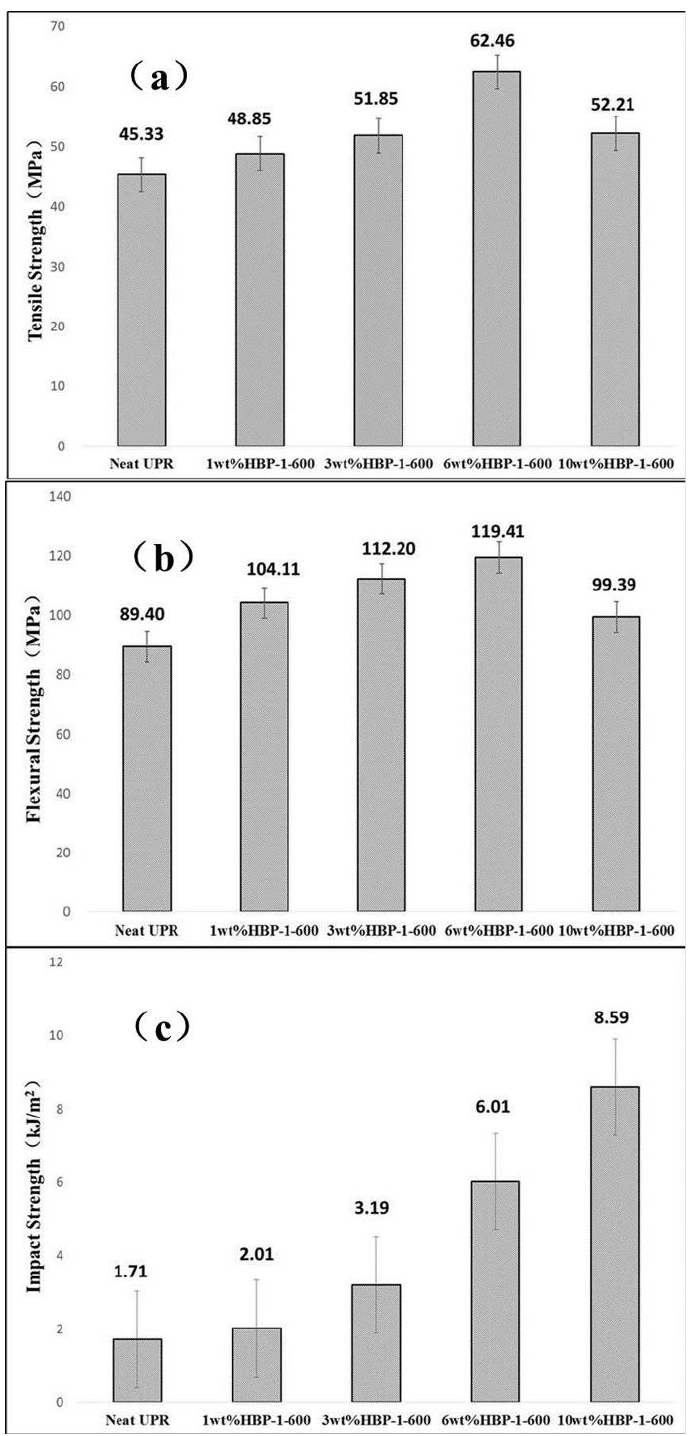
Figure 7. The effect of different ratios of HBP-1-600 on mechanical properties of UPR: ( a ) tensile strength; ( b ) flexural strength; ( c ) impact strength.